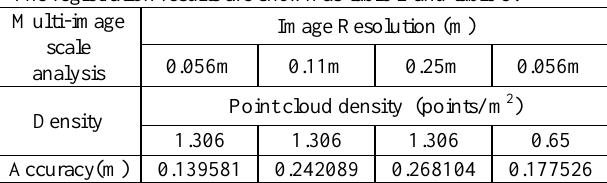
Table 2 Registration result of multi- images based on point